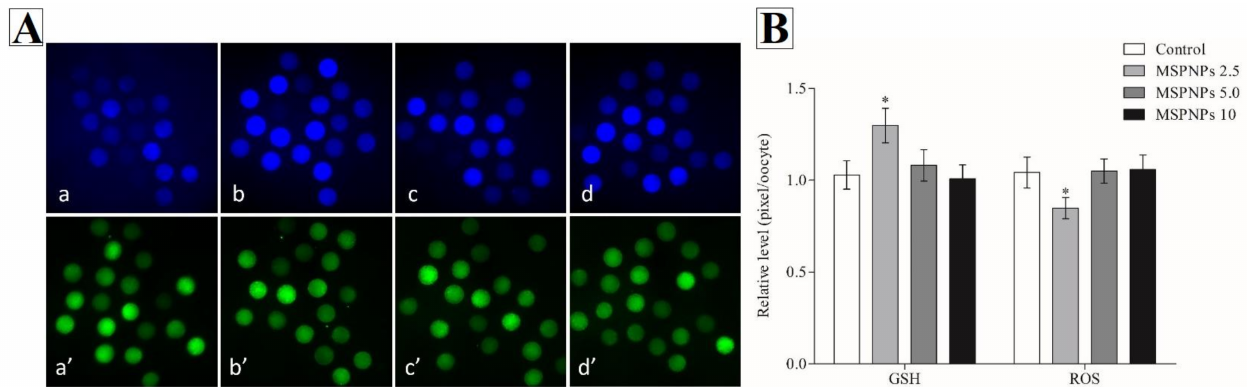
Figure 1. Evaluation of glutathione and reactive oxygen species of in vitro matured porcine oocytes at different concen- trations of MSPNPs. ( A ) Oocytes were stained with ( a – d ) Cell Tracker Blue and ( a’ – d’ ) 2 (cid:48) ,7 (cid:48) -dichlorodihydrofluorescein diacetate (H2DCFDA) to detect intracellular levels of glutathione (GSH) and reactive oxygen species (ROS), respectively, whereas ( a , a’ ) control and ( b , b’ ) MSPNPs-2.5, ( c , c’ ) MSPNPs-5.0, and ( d , d’ ) MSPNPs-10 matured oocytes. ( B ) Effects on intracellular levels of GSH and ROS in vitro matured porcine oocytes. * Indicates that there is a significant difference in the GSH and ROS levels between each group ( p < 0.05). GSH samples, n = 60; ROS samples, n = 60. The experiment was independently replicated three